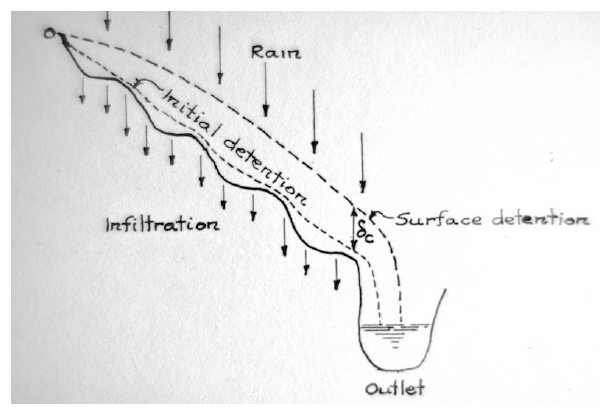
Figure 1. Half-section of a small drainage basin illustrating runoff phenomena (vertical scale greatly exaggerated). Source: Hor- ton (1935), with original